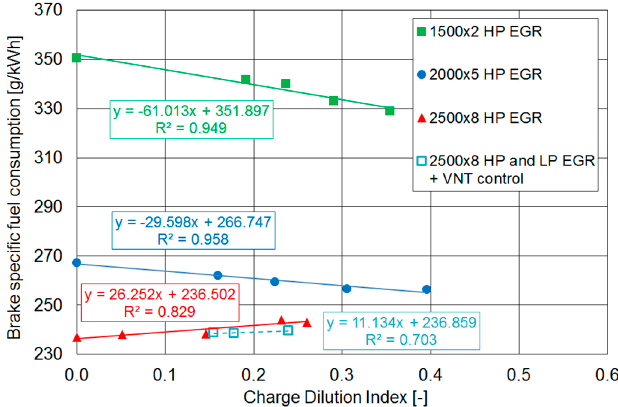
Figure 7. Link between Charge Dilution Index and brake specific fuel consumption (bsfc) in different test sets.